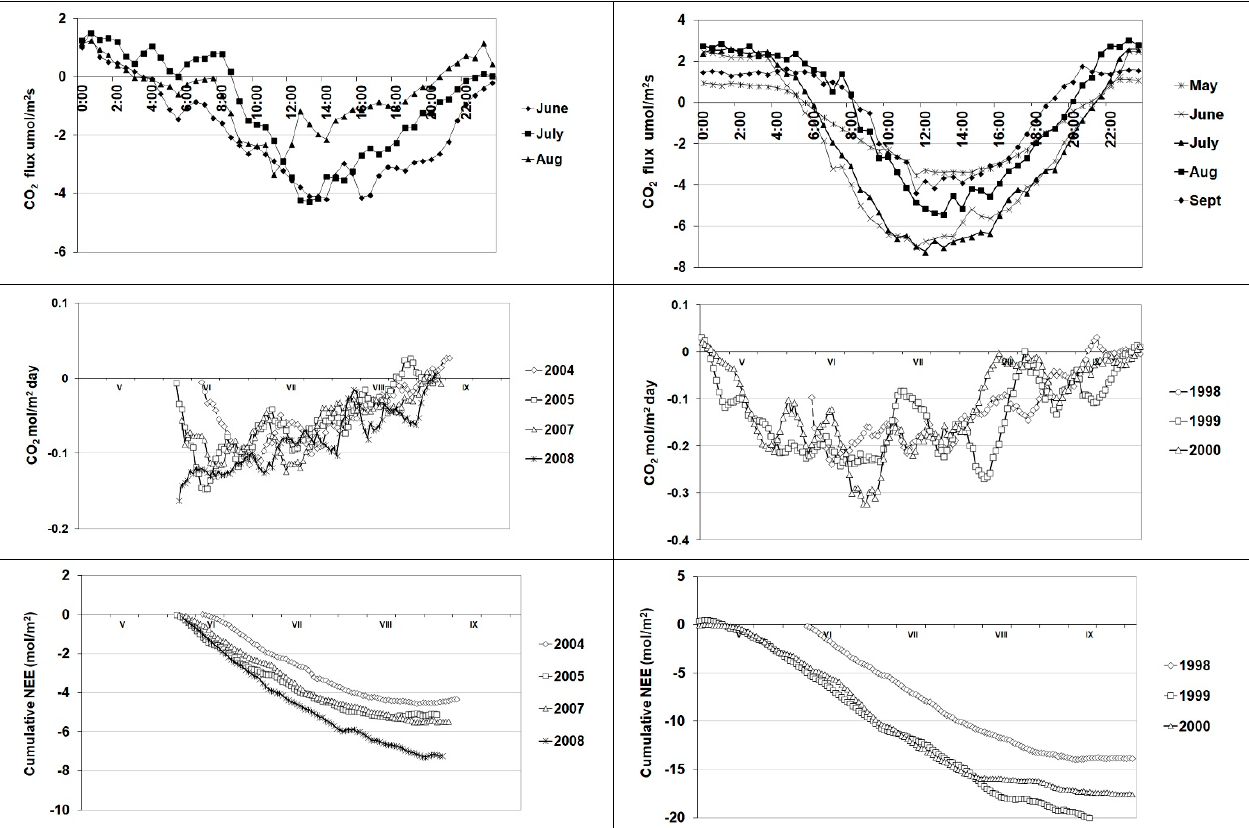
Figure 6. Daily ( upper ), seasonal ( middle ) and cumulative ( lower ) NEE in the Gmelin larch ( left ) and Scots pine ( right ) ecosystems for the growing season (May–September, V–IX).